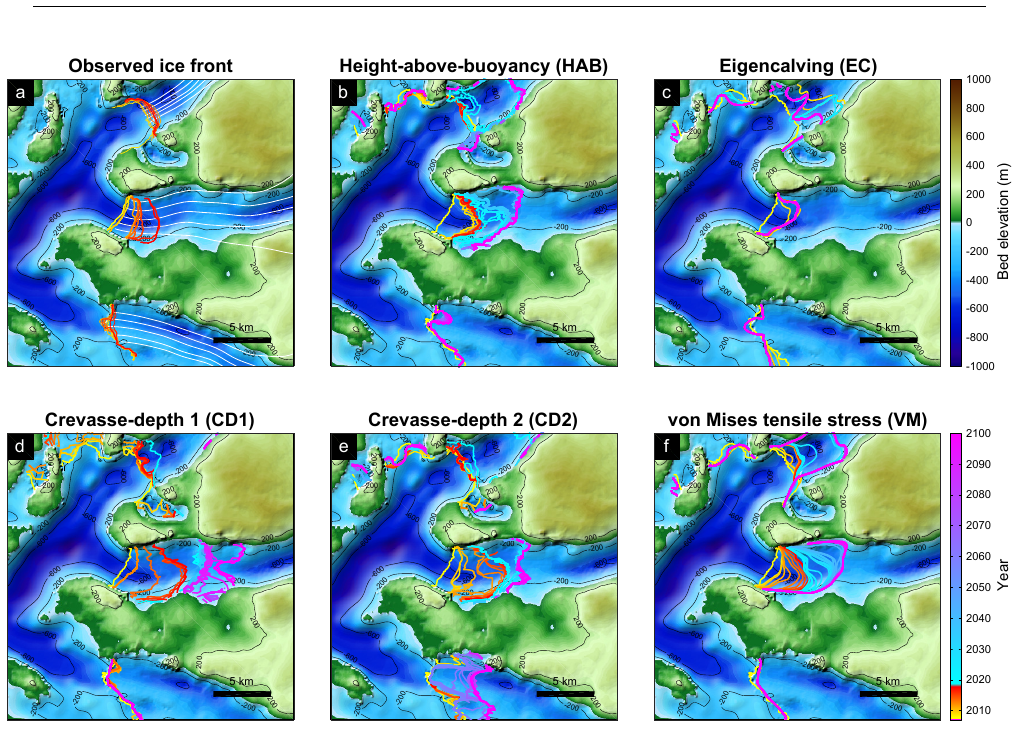
Figure 2. (a) The observed ice front positions between 2007 and 2017 and (b–f) modeled ice front positions obtained with different calving laws between 2007 and 2100 overlaid on the bed topography of Upernavik Isstrøm. The white lines are the flowlines used to calculate retreat or advance distance of the ice